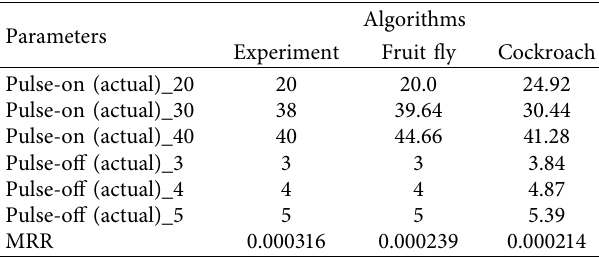
Table 25: Comparison between the values predicted using fruit fly and cockroach algorithms with the experimental values for aluminium.